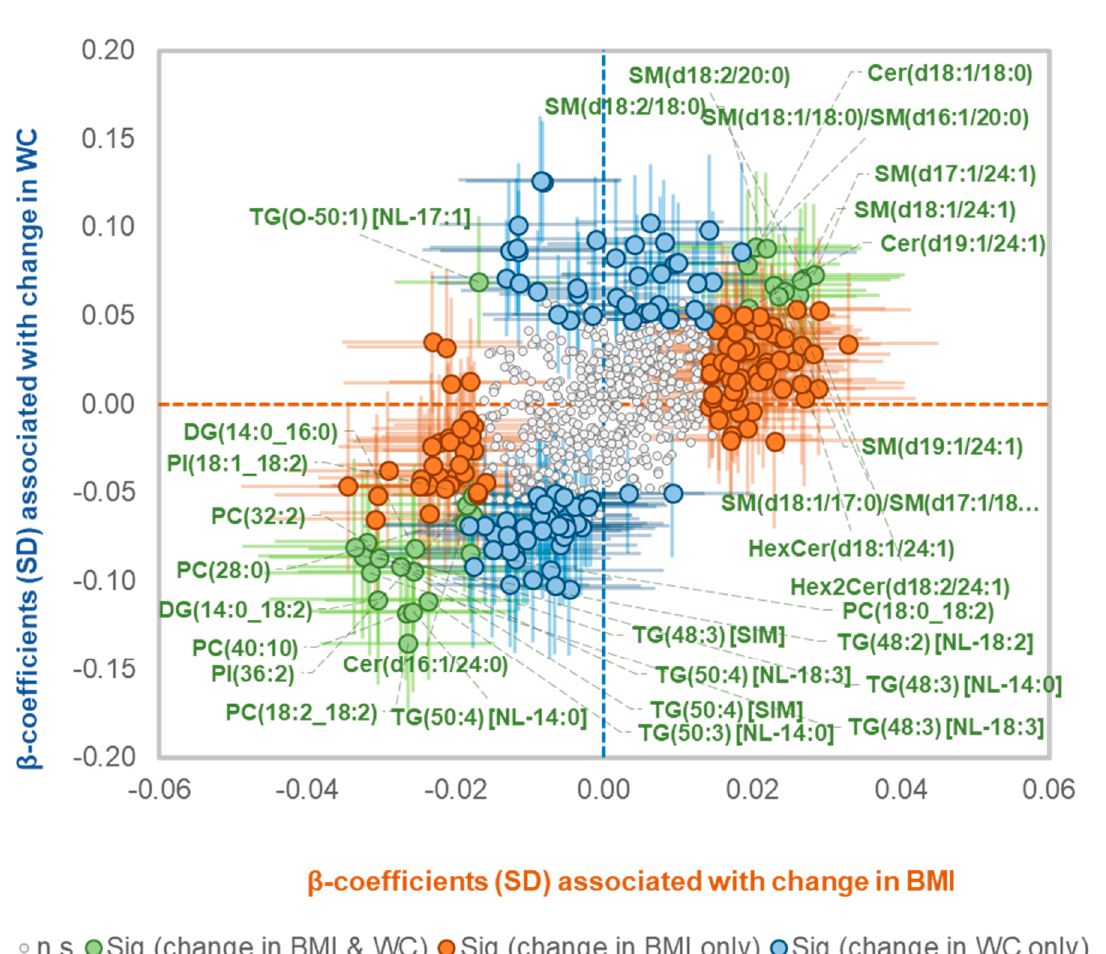
Figure 3. Association of lipid species with change in waist circumference and BMI. Linear regression analyses of SD normalized lipid species concentrations against annualized change in WC or BMI were performed, adjusting for baseline age, sex, baseline WC/BMI, total cholesterol, HDL-C, triglycerides, education, smoking status, exercise time and television viewing time. The β -coefficients of the associations with change in BMI were plotted against the β -coefficients of the associations with change in WC. β -coefficients for lipid species that were associated with both a change in WC and change in BMI are shown in green. β -coefficients for lipid species that were associated only with a change in BMI are orange and only with a change in WC are blue. The whiskers represent 95% confidence